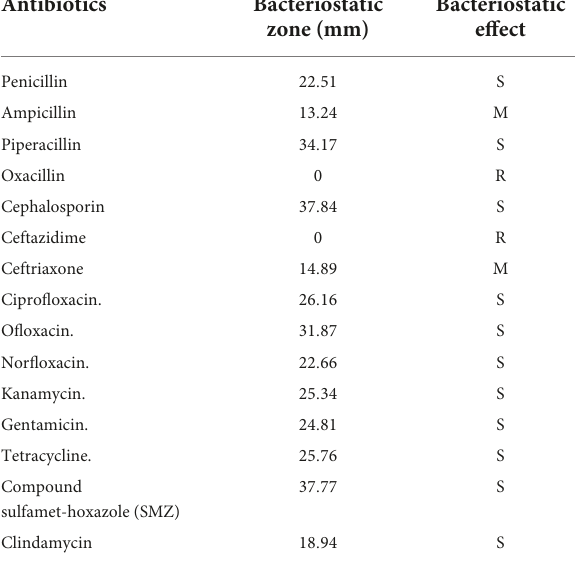
TABLE 3 Antibiotic susceptibility test for SN-6.